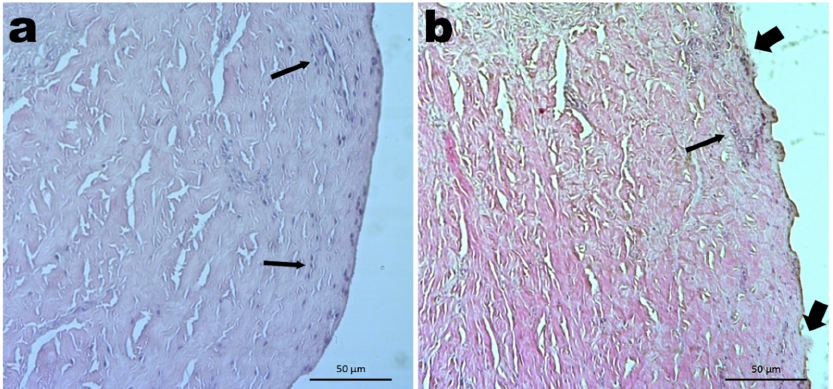
Figure 4. Photomicrographs (×200 magnification) of ( a ) the histological section of porcine ear skin contacted with only saline solution (0.9% NaCl, w / w ) and ( b ) the histological section of the porcine ear skin after transdermal permeation of curcumin using CG-DES at 2.0% ( w / v ). All sections were stained with hematoxylin and eosin. For the legend of inserted (thick, thin, and skinny) arrows, please refer to the Discussion section.